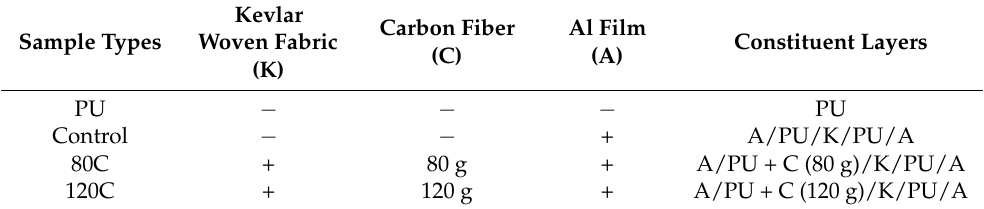
Table 1. The specification of the PU foam